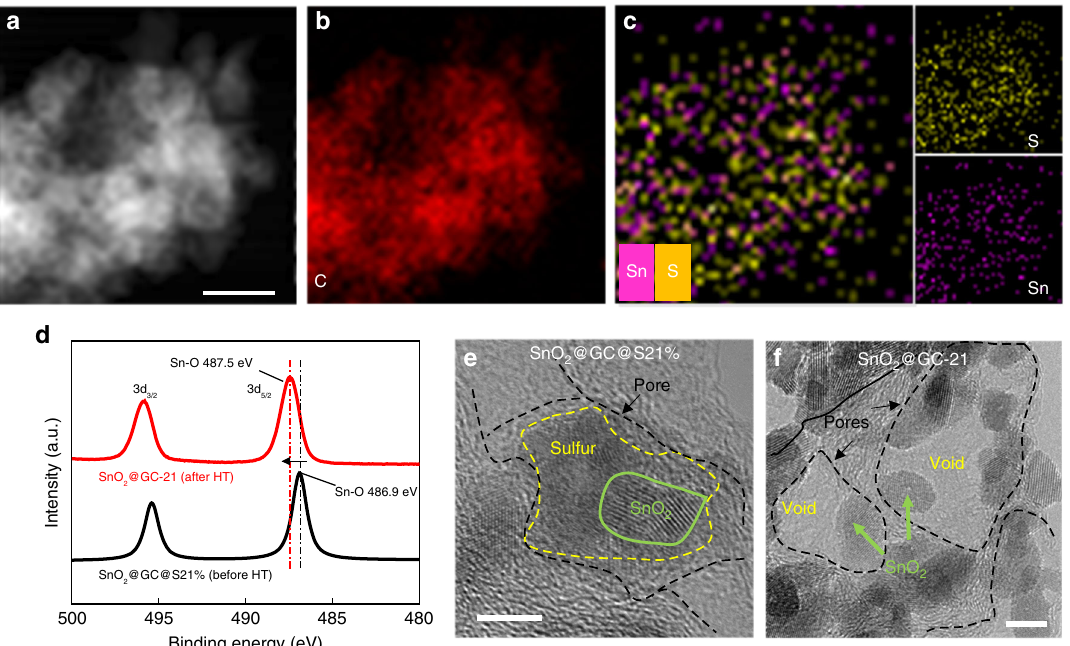
Fig. 2 Characterization of the state of the sulfur and the SnO 2 NPs in the 3D graphene cages. a STEM and b , c EDS of SnO 2 @GC@S21% before heat treatment (HT) showing the distribution of elemental C, S and Sn, especially the distribution of S and Sn. d Sn 3d XPS spectra with a 0.6 eV shift between SnO 2 @GC-21 (after HT) and SnO 2 @GC@S21% (before HT). e HRTEM image of SnO 2 @GC@S21%. f HRTEM image of SnO 2 @GC-21. Scale bars: a 100